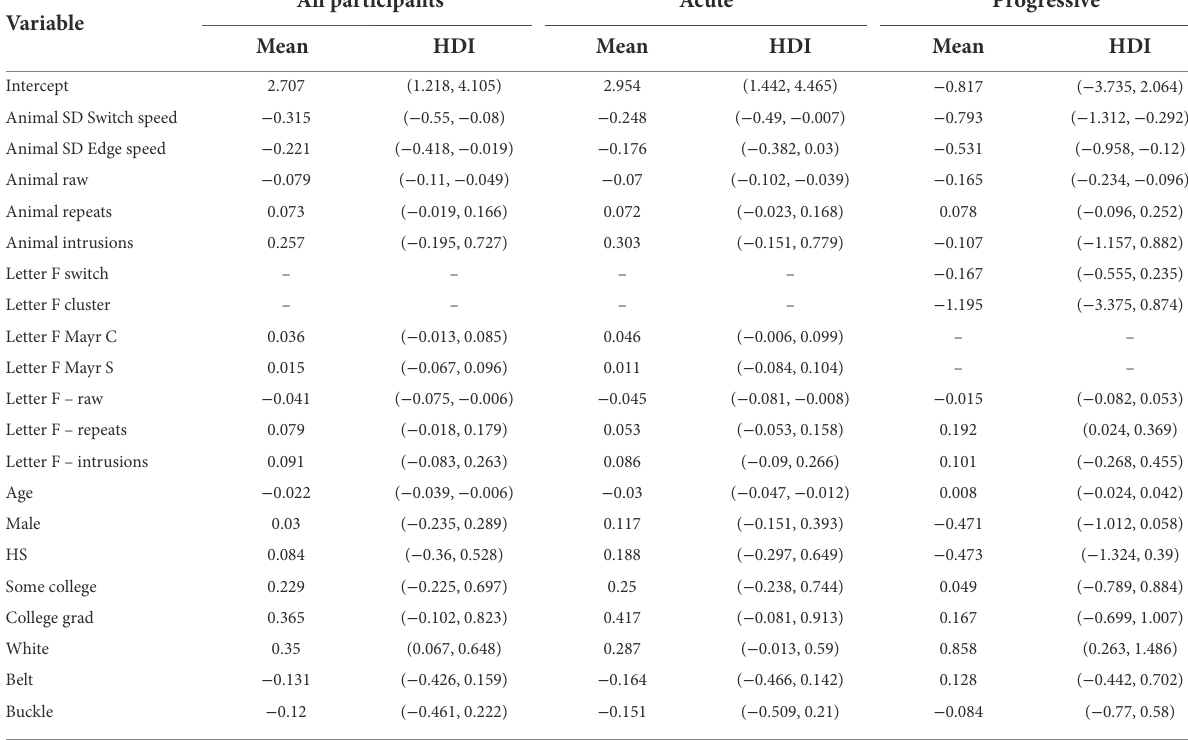
TABLE 5 Mean and 97% highest density interval (HDI) of combined model posterior